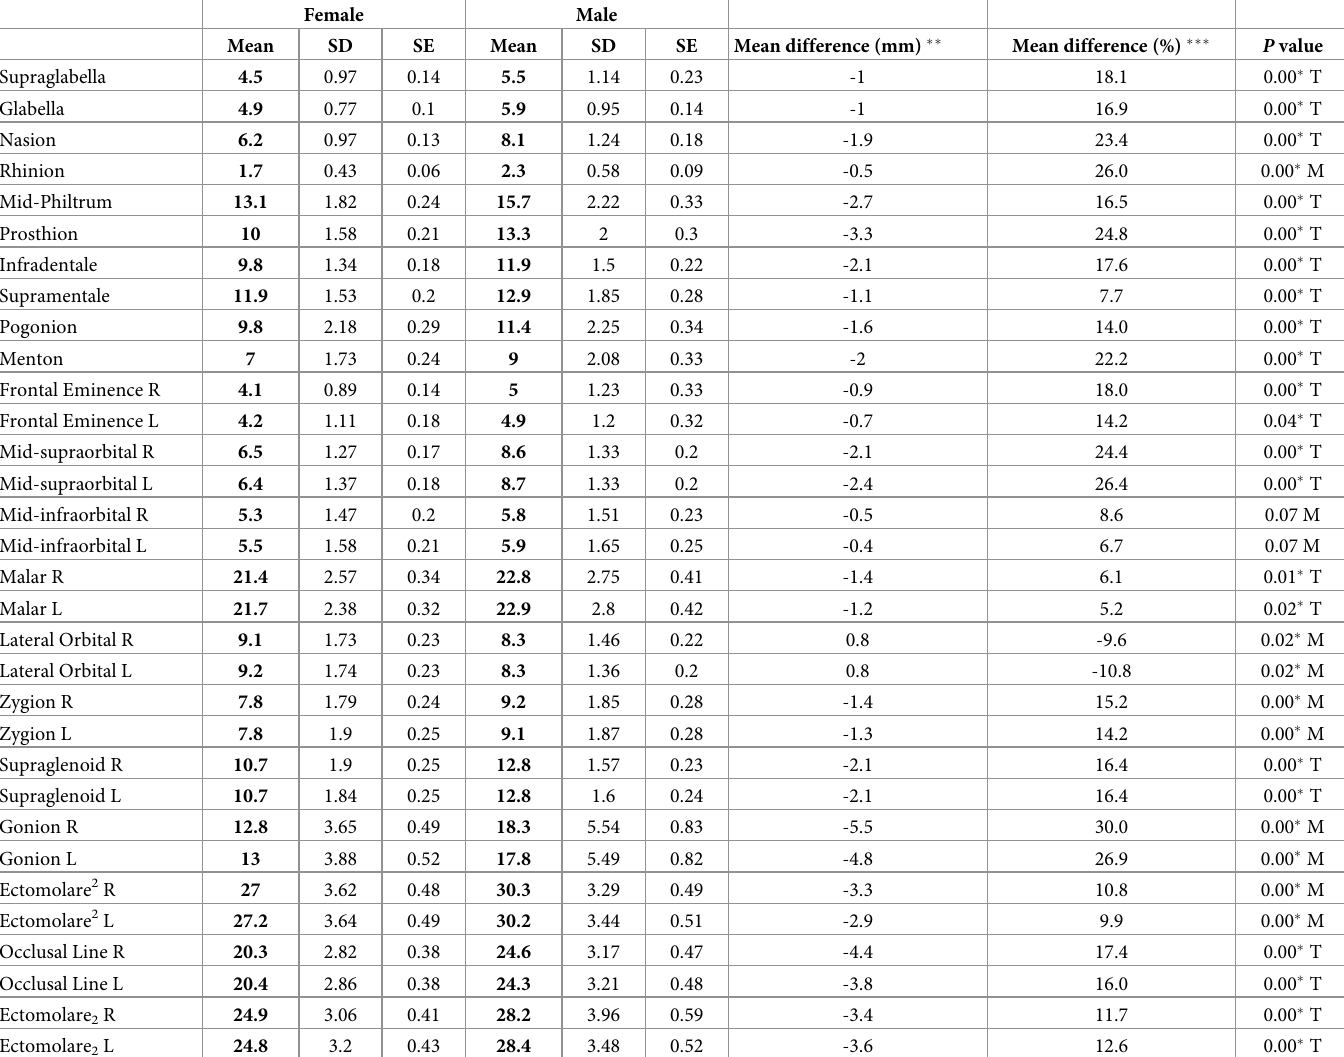
Table 3. Mean FSTT (millimeters and percentage), SD, and SE divided by